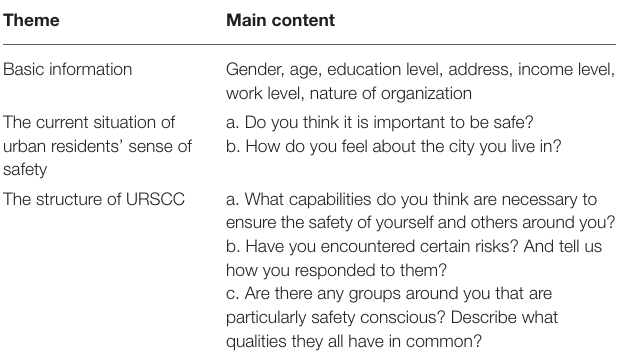
TABLE 2 | Outline of interview on the safety cognition capability of urban residents.